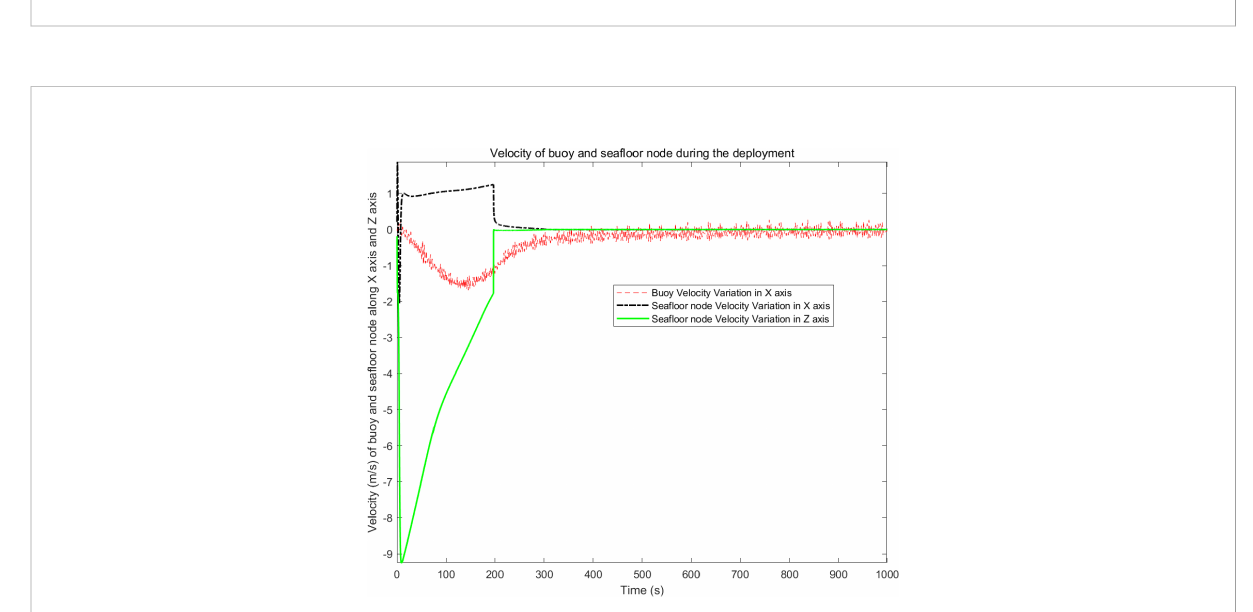
FIGURE 15 Velocities of the buoy and benthic node during system deployment.